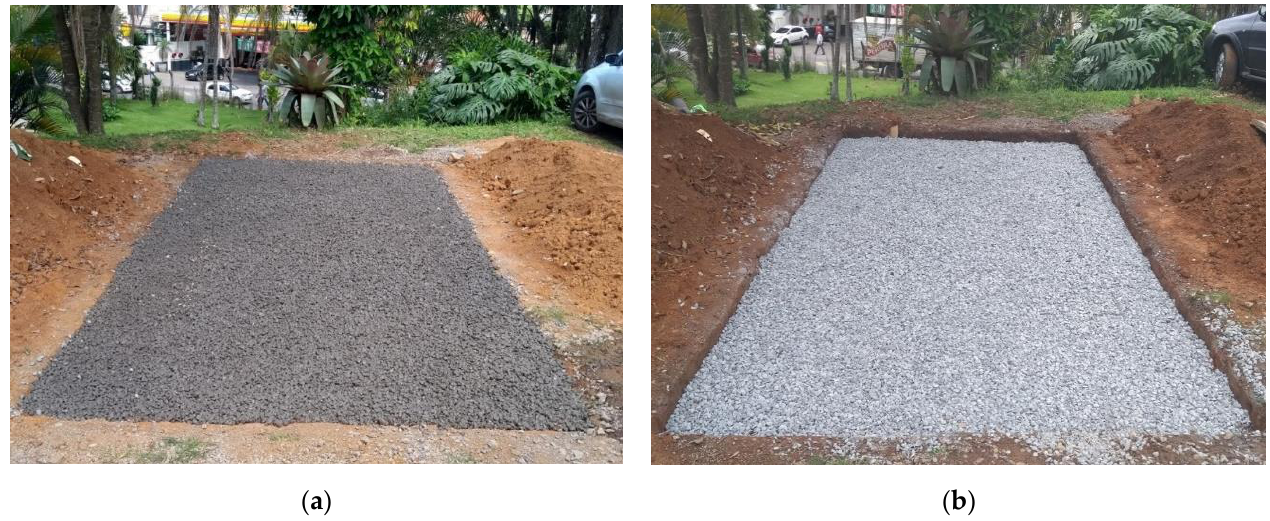
Figure 4. Parking space lined with recycled concrete aggregate (RCA)-based pervious concrete ( a ) and seated sub-base layer ( b ).